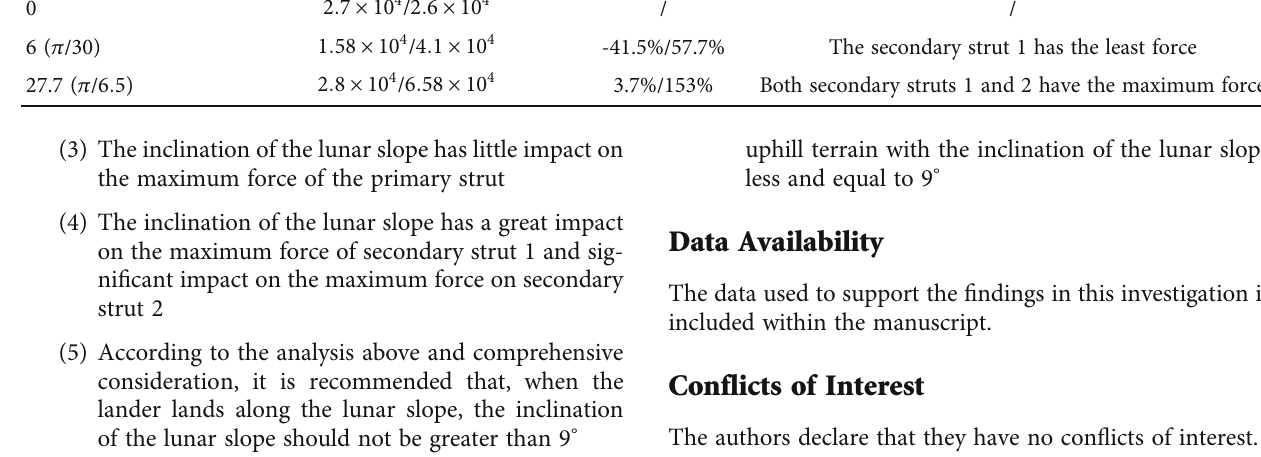
Table 16: Impact on the maximum force of secondary struts under typical lunar inclination conditions. Lunar inclination ( °